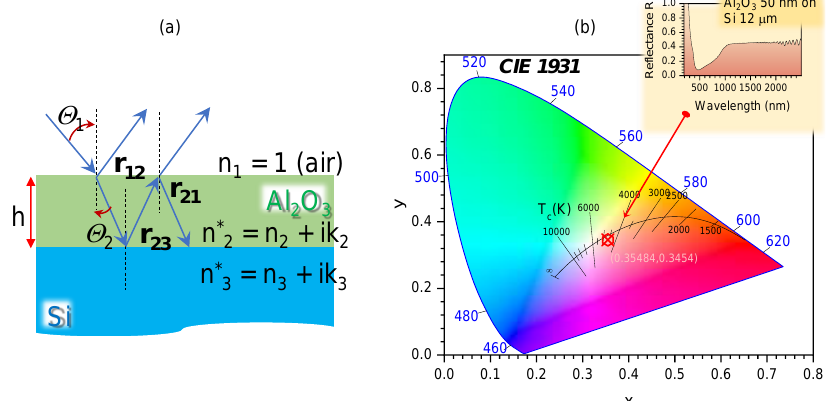
Figure A1. ( a ) Schematics and conventions for reflection coefficient r (Equation (A1)) from a thin film (Al 2 O 3 ) of thickness h on Si; reflectance R ≡ | r | 2 , and n ∗ is the complex refractive coefficient of the i th i layer. ( b ) Chromaticity plot for reflectance R from a 50 nm Al 2 O 3 -coated 12 µ m Si film (inset shows spectrum R ( λ ) ). The marker points to the ( x , y ) = ( 0.35484,0.3454 )